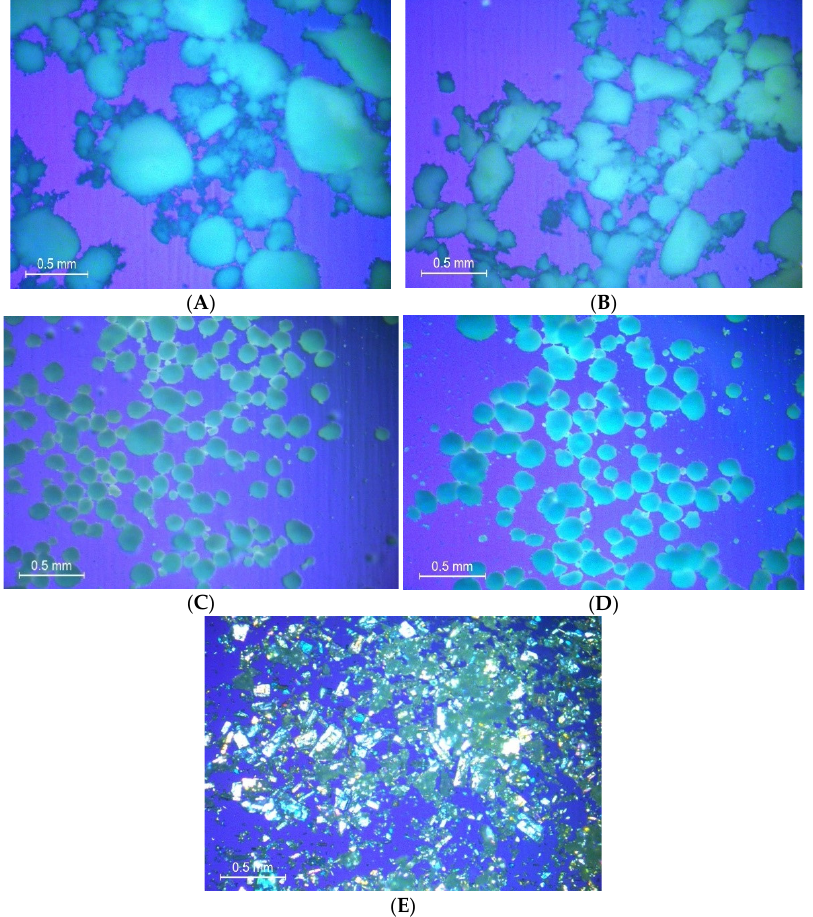
Figure 7. Images from polarized light microscopy on powder morphology of API and excipients used in capsule preparation. ( A ) Pure Syloid 244 FP . ( B ) Syloid 244 FP + enalapril maleate . ( C ) Pure Fujicalin . ( D ) Fujicalin + enalapril maleate . ( E ) Pure enalapril maleate .